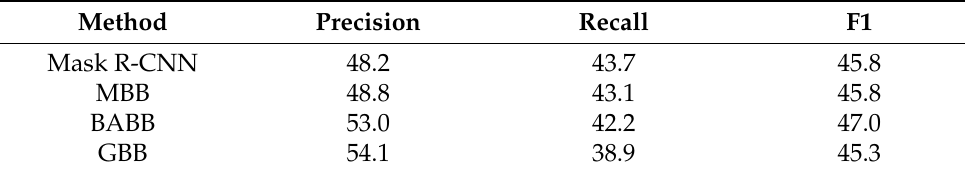
Table 4. Building detection evaluation metrics